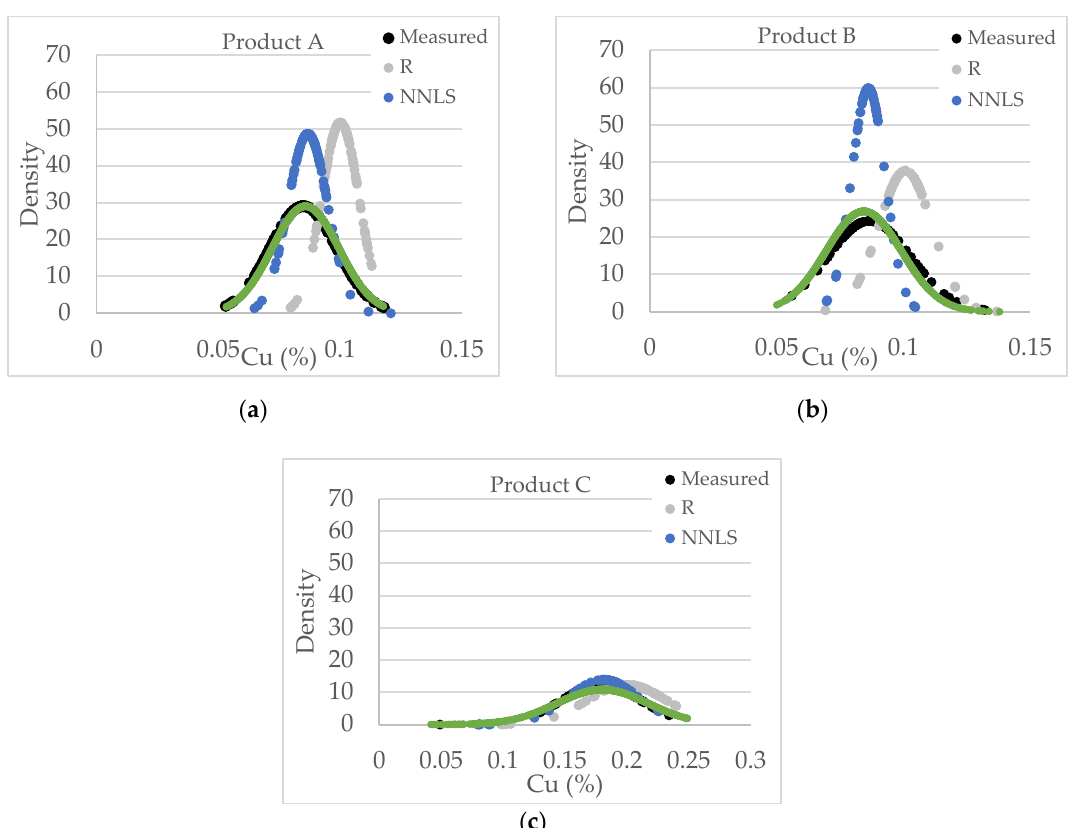
Figure 6. Comparison between the concentrations of Cu calculated using the reported scrap compositions (R) and the calculated scrap compositions using the NNLS and ML methods. Data are presented for three target products: A, B and C, ( a–c ).